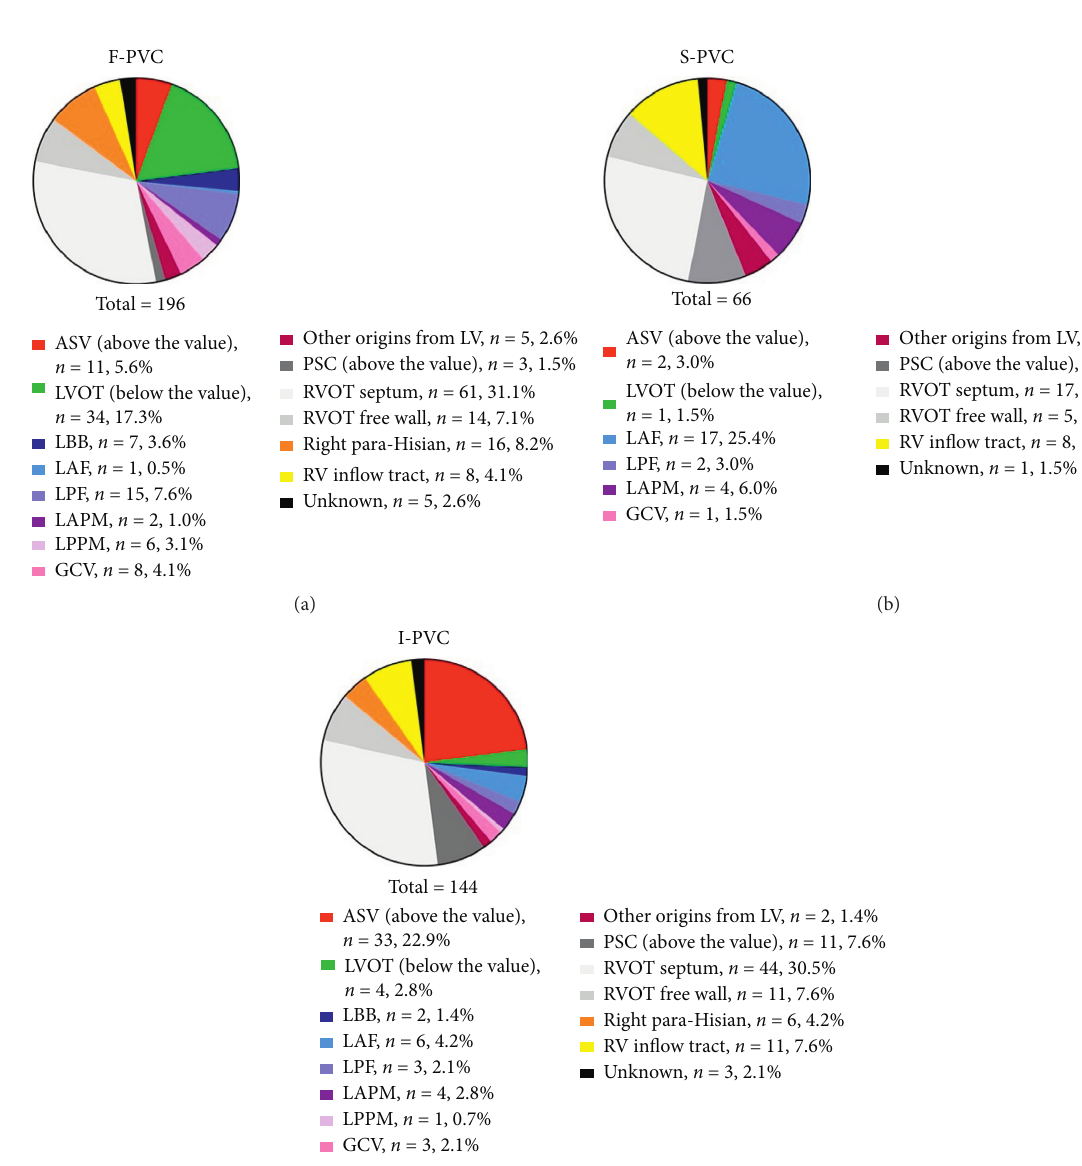
Figure 2: Origin distributions for PVC circadian patterns. Origin distributions for F-PVC (a), S-PVC (b), and I-PVC (c), respectively. ASV, aortic sinus of Valsalva; GCV, great cardiac vein; LAF, left anterior fascicle; LAPM, left anterior papillary muscle; LBB, left bundle branch; LPF, left posterior fascicle; LPPM, left posterior papillary muscle; LV, left ventricle; LVOT, left ventricular outflow tract; PSC, pulmonary sinus cusp; PVC, premature ventricular complexes; RV, right ventricle; RVOT, right ventricular outflow